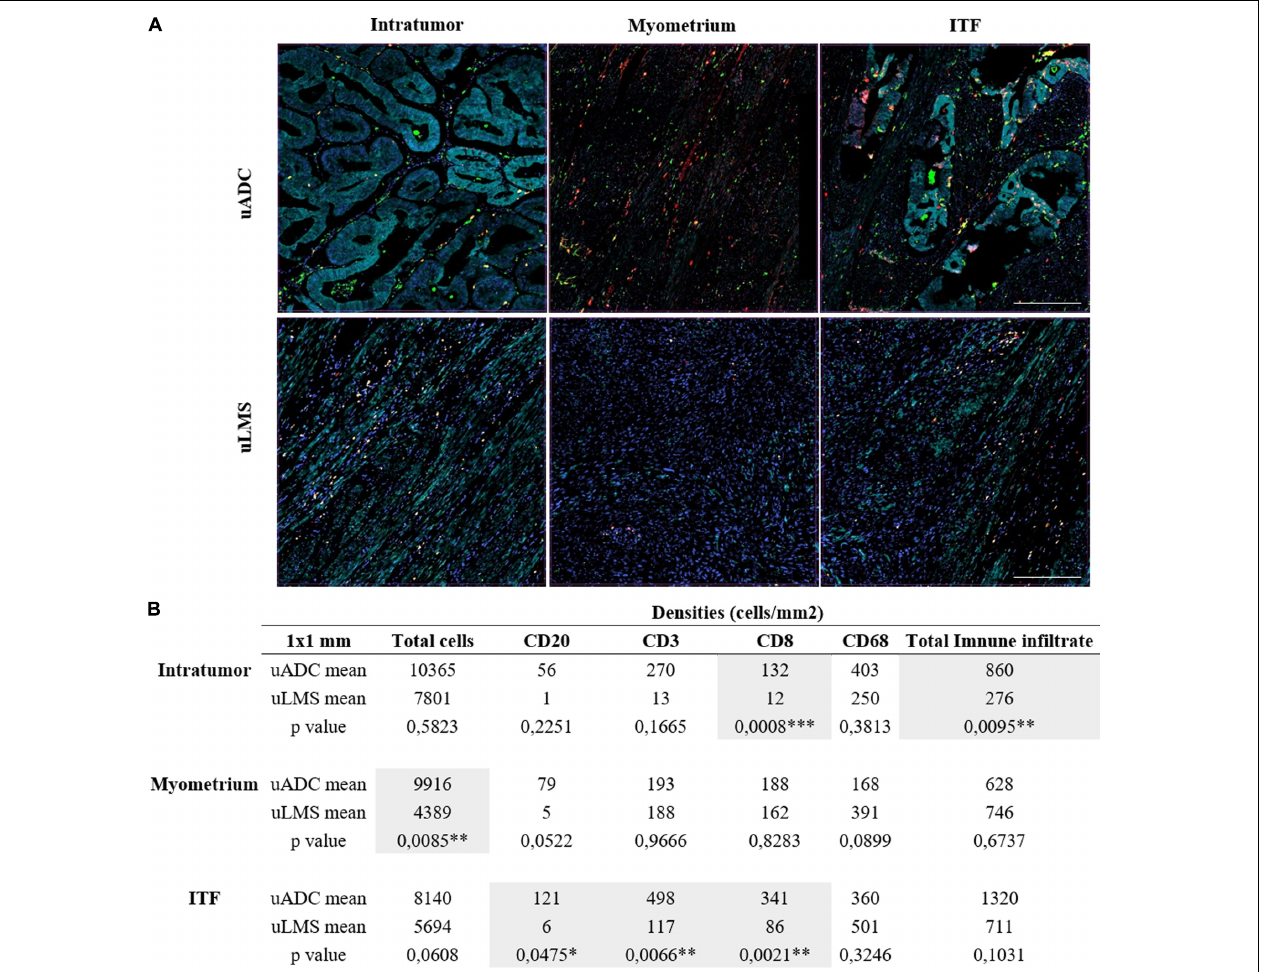
FIGURE 4 | Immune infiltrate characterization in 1 × 1-mm regions of interest (ROIs) in uterine adenocarcinomas (uADC) and leiomyosarcomas (uLMS). (A) Representative multiplex images of 1 × 1-mm ROIs of intratumor, myometrium, and invasive tumor front (ITF) in uADC and uLMS. Color code as follows: DAPI (blue), CD20 (yellow), CD68 (green), CD8 (red), CD3 (orange), cytokeratin (cyan). (B) The mean of the densities (number of cells/mm 2 ) for each cell marker in each region is shown for uADC and uLMS as well as the mean for the total cells and the total immune infiltrate. Fisher–Snedecor test and Student T -Test were applied for statistical comparison. P -values and significance ( ∗ < 0.05, ∗∗ < 0.01, ∗∗∗ < 0.001) for statistical comparison between the means of intratumor, myometrium, and ITF in uADC and uLMS are displayed. Scale bars represent 250 µ